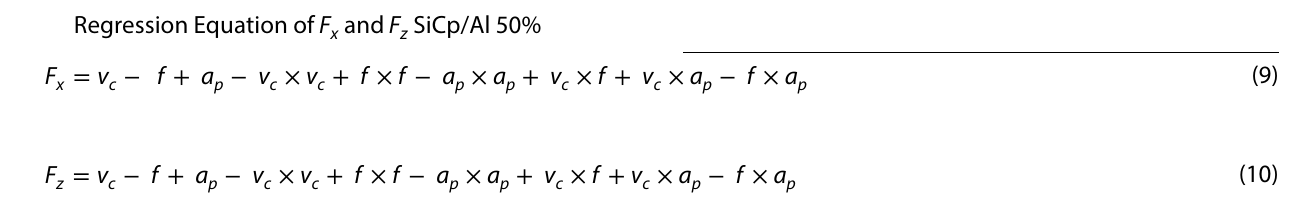
normal probability graph, residual error fitting graph, residual error histogram, and residual error observation sequence